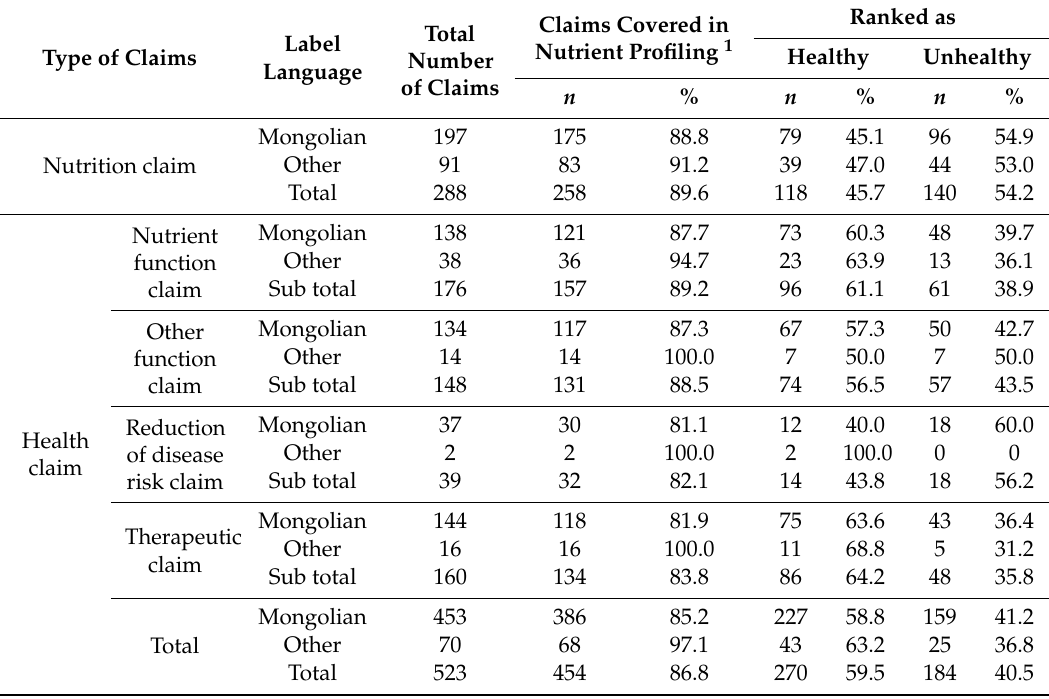
Table 6. Application of nutrient profiling model to the products with nutrition and health